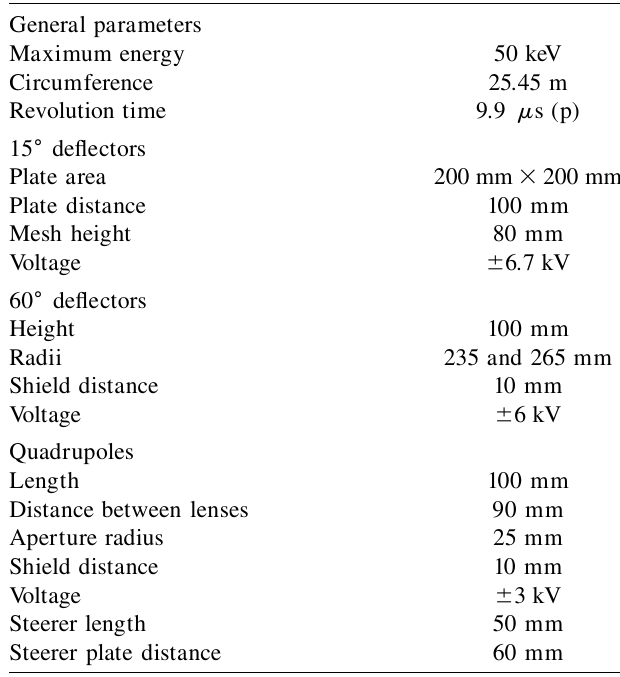
TABLE I. Summary of design parameters. General parameters